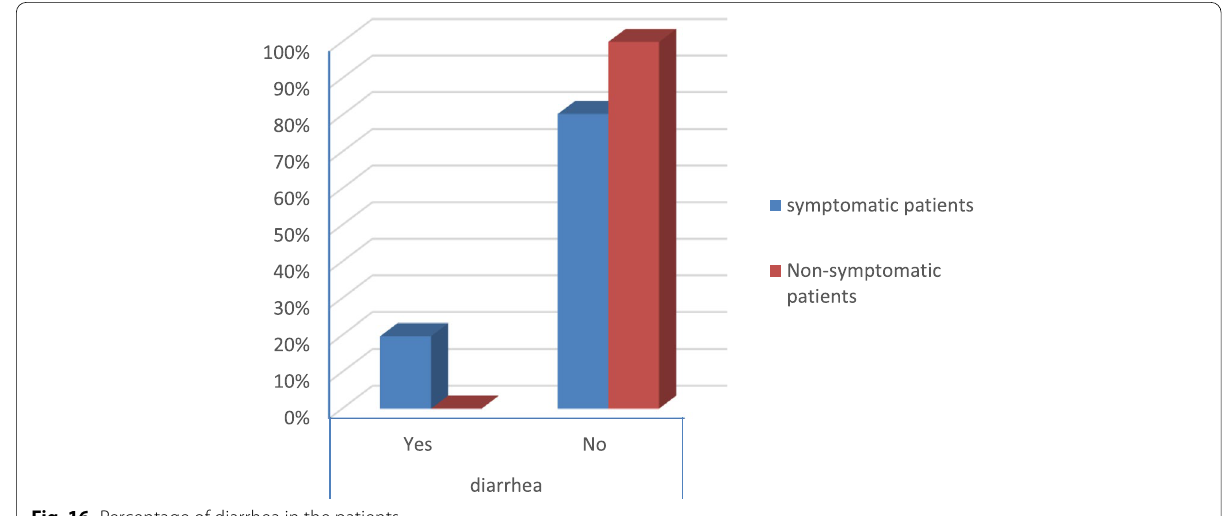
Fig. 16 Percentage of diarrhea in the patients